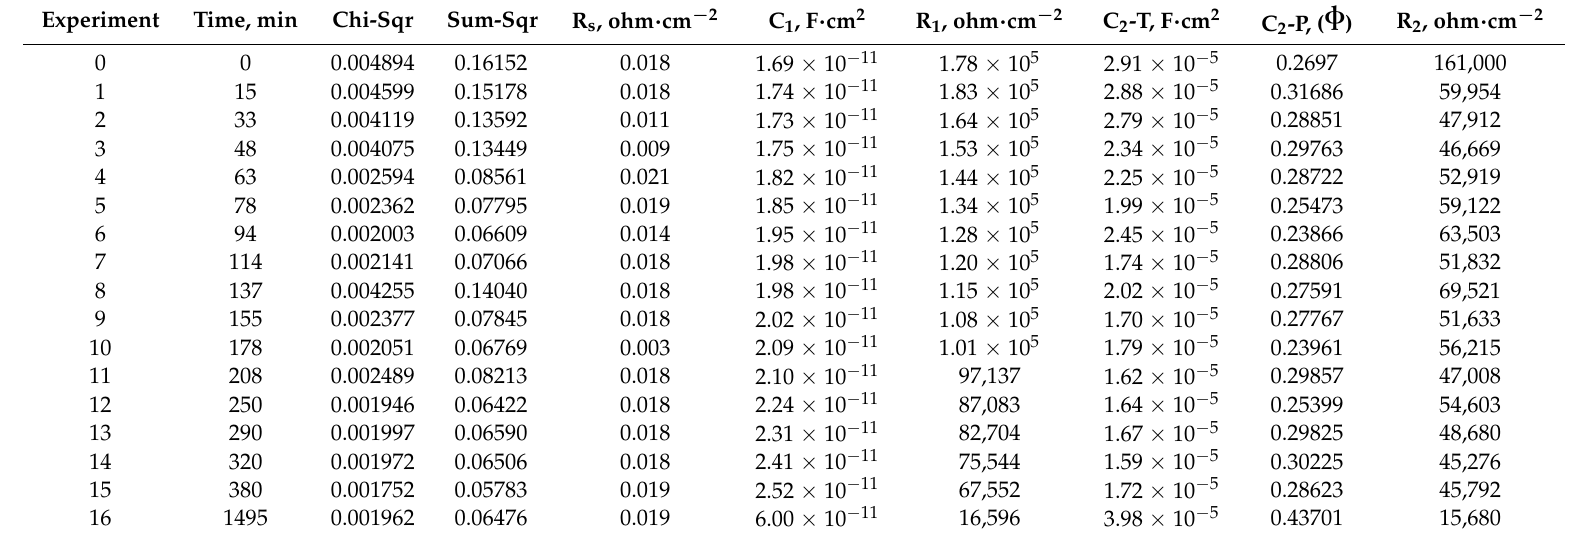
Table 3. Values of the electric circuit elements for the NPOE electrode.